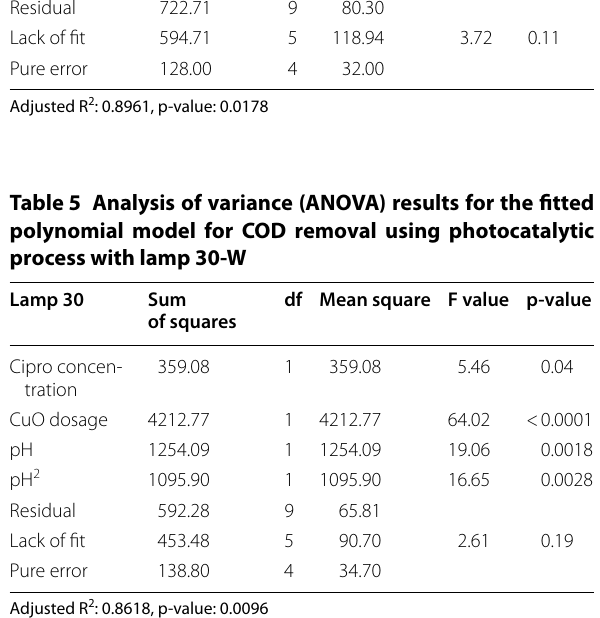
Adjusted R 2 : 0.8618, p-value: 0.0096